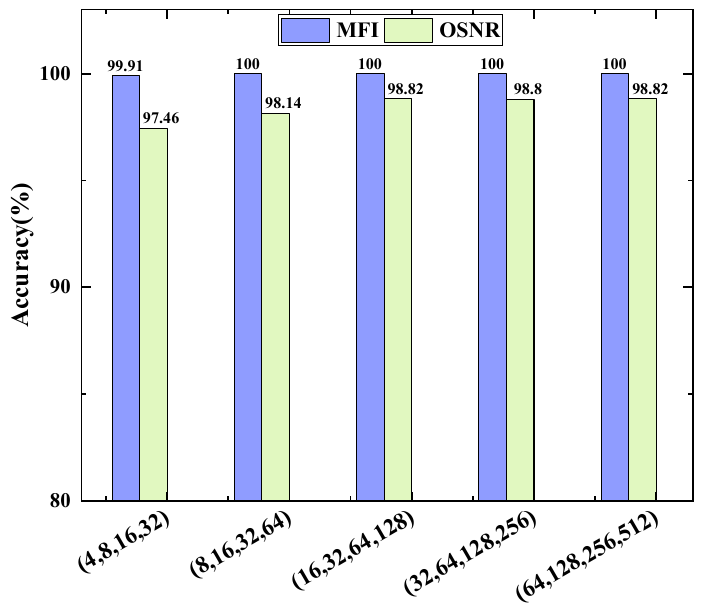
Figure 11. MFI and OSNR accuracies for di ff erent numbers of convolutional kernels.